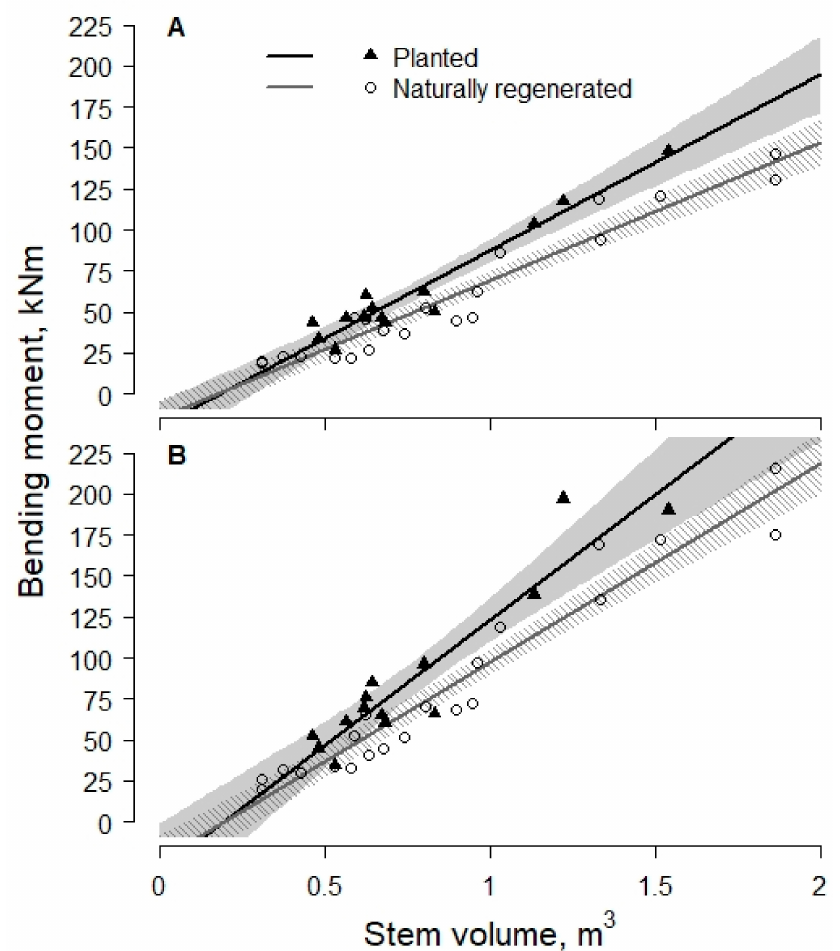
Figure 1. Basal bending moment of silver birch at the ( A ) primary failure and the ( B ) secondary failure. The shaded area indicates 95% confidence